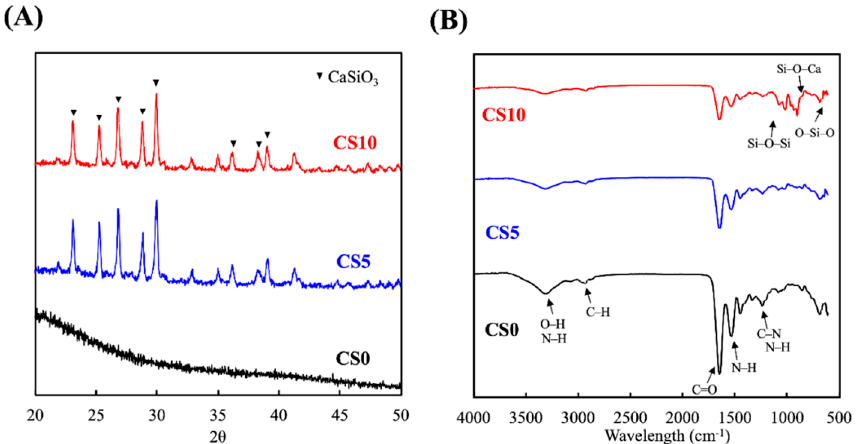
Figure 1. Schematic diagram depicting the fabrication of CS/GelMa scaffolds and advantages of hDPSCs-laden CS/GelMa scaffolds for odontogenesis.